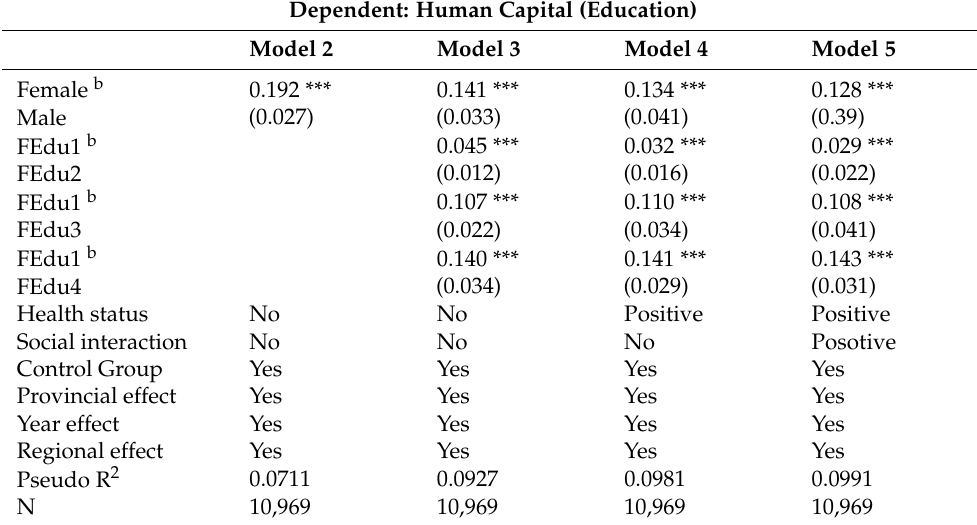
Table 6. Logit model on the relationship between father’s education and individual’s education, CGSS 2013 and